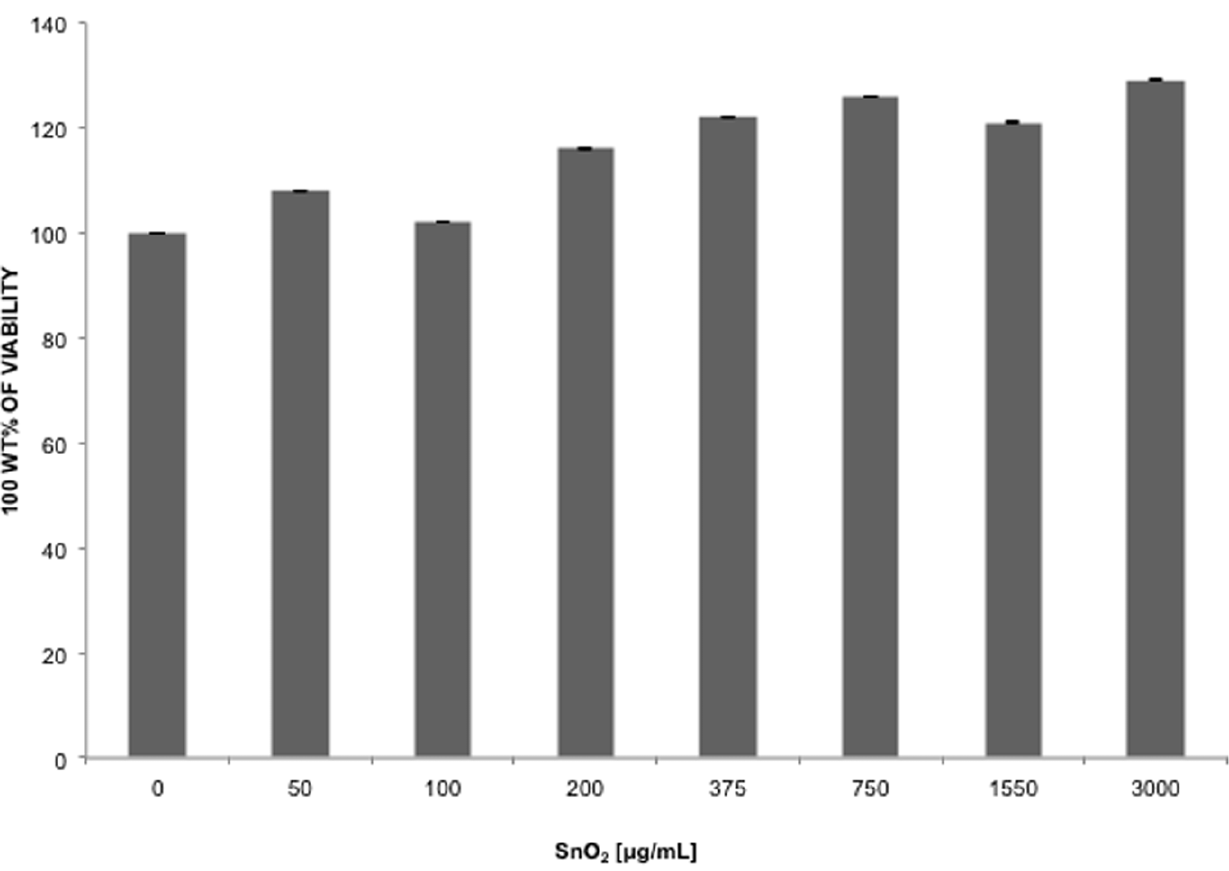
Figure 2. SnO 2 cytotoxicity determination. To determine the effect of SnO 2 nanowires on cell viability a cytotoxicity assay was performed. HCE were treated for 24 hours in the presence of SnO 2 . Cell viability was evaluated by a chromogenic kit (CellTiter Aqueous96; Promega, Madison, WI, USA) and colorimetric detections were performed using a mircroplate ELISA reader (Spectra Max 190). Results are expressed as 100% wild type (WT) viability where they represent the percent corrected absorbance after subtracting the background absorbance relative to untreated cells (0 m